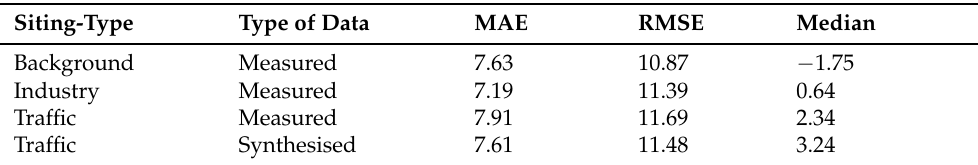
Table 4. Leave-one-out cross-validation (loo-cv) results of run 7 with dataset (1) concerning the type of station and the type of data (MAE, RMSE, and median in µgm − 3